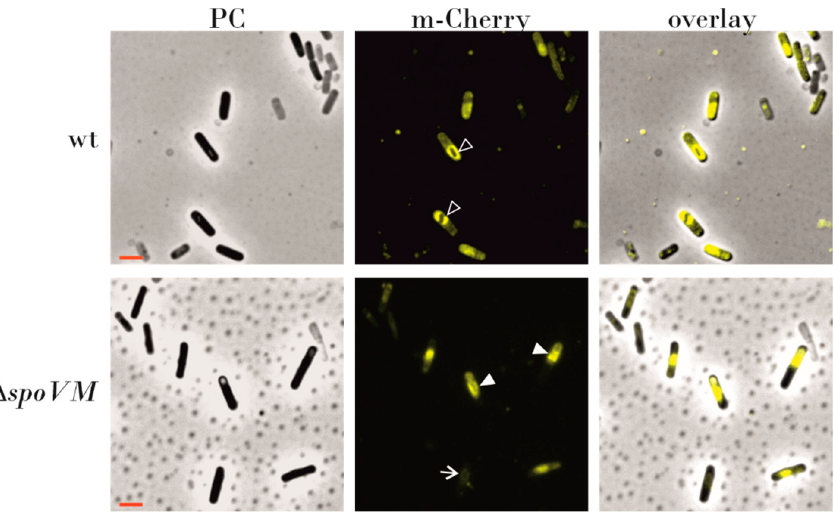
Figure 5. Localization of mCherry-SpoVD in sporulating cells. Cells grown in Difco sporulation media (DSM) were examined four hours after reaching stationary phase. The left panels show phase contrast images (PC); the middle panels show m-Cherry detection (false colored yellow); the right panels are merged images of PC and m-Cherry. The mCherry-SpoVD signal is around the forespore (open arrow heads) in wild type cells. In spoVM mutant cells, the fusion protein signals are mis-localized in the mother cell as clumps of proteins which are sometimes attached to the forespore (white arrowheads). The complete white arrow shows the proper localization of the mCherry-SpoVD protein. The red scale bar represents 2 μ m.